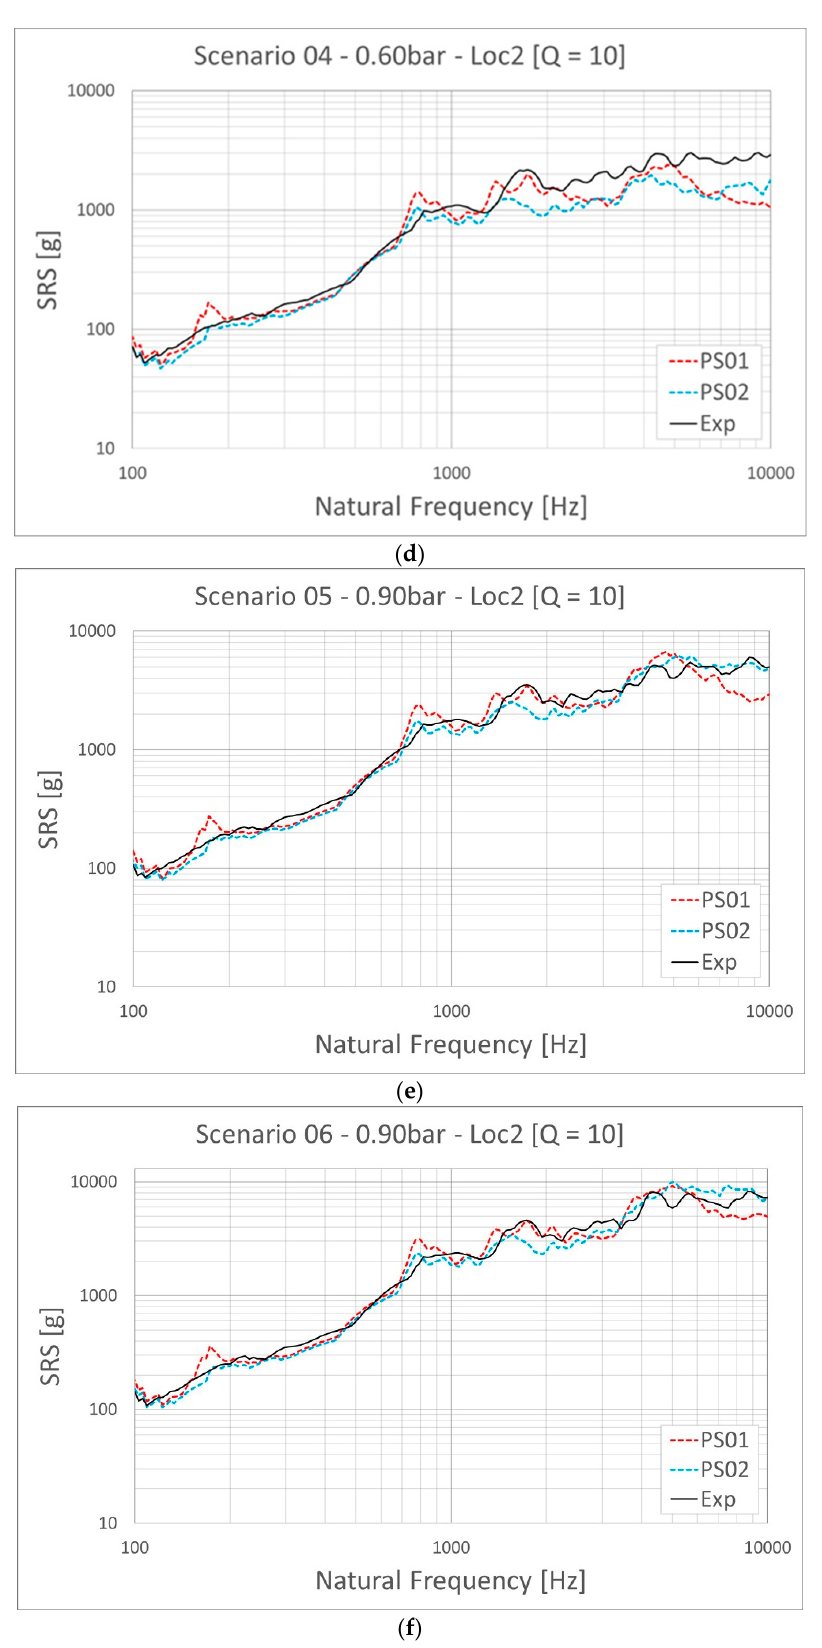
Figure 9. Comparison of experimental and numerical SRS results. ( a ) Scenario 01, ( b ) Scenario 02, ( c ) Scenario 03, ( d ) Scenario 04, ( e ) Scenario 05, ( f ) Scenario